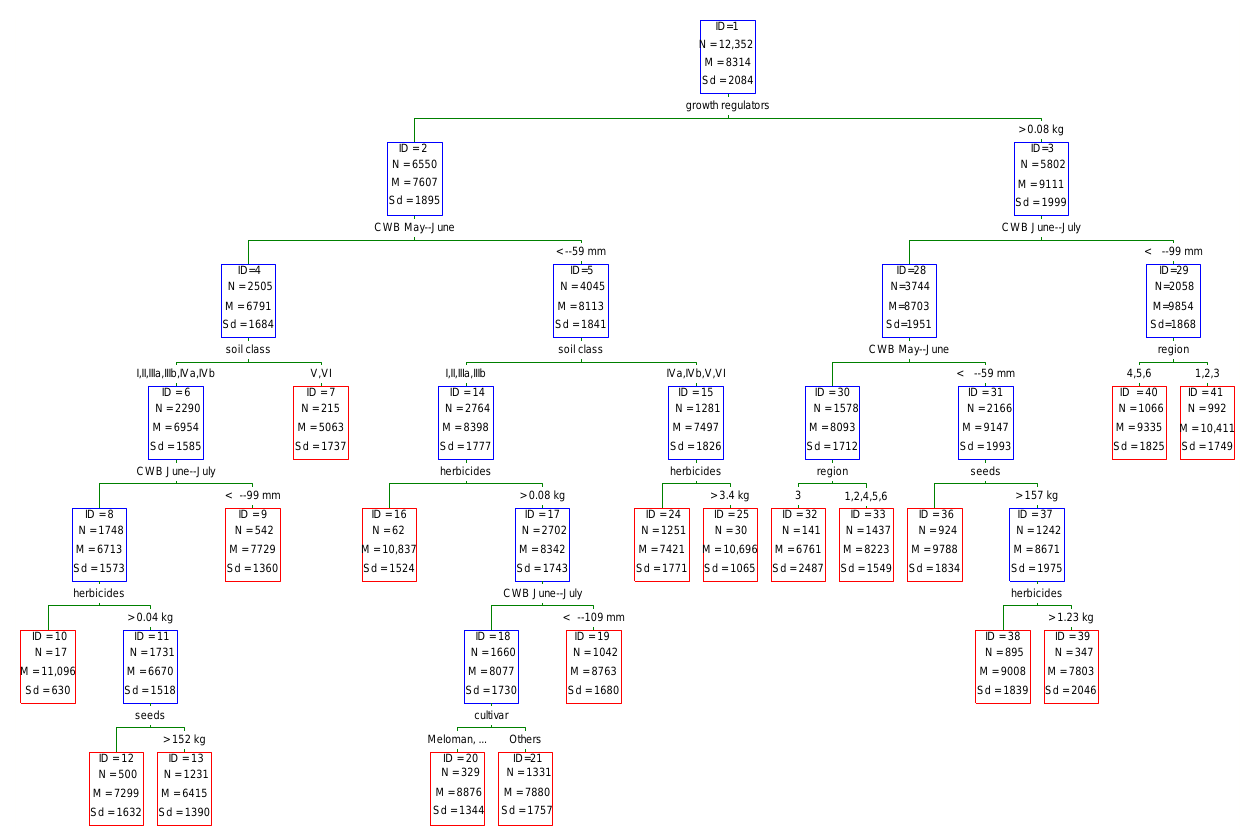
Figure 2. CART (Classification and regression tree) for winter triticale. CWB stands for Climatic Water Balance. N indicates the number of observation units in each subset. There are also mean (M) and standard deviation (Sd) in each subset given. In split ID, 20 cultivars giving higher yields are as follows Meloman, Subito, Panteon, Trapero, Pizarro, Avokado, Festino, Kasyno, Rufus, Sekret, Temuco, Sorento, Witon, Trisol.